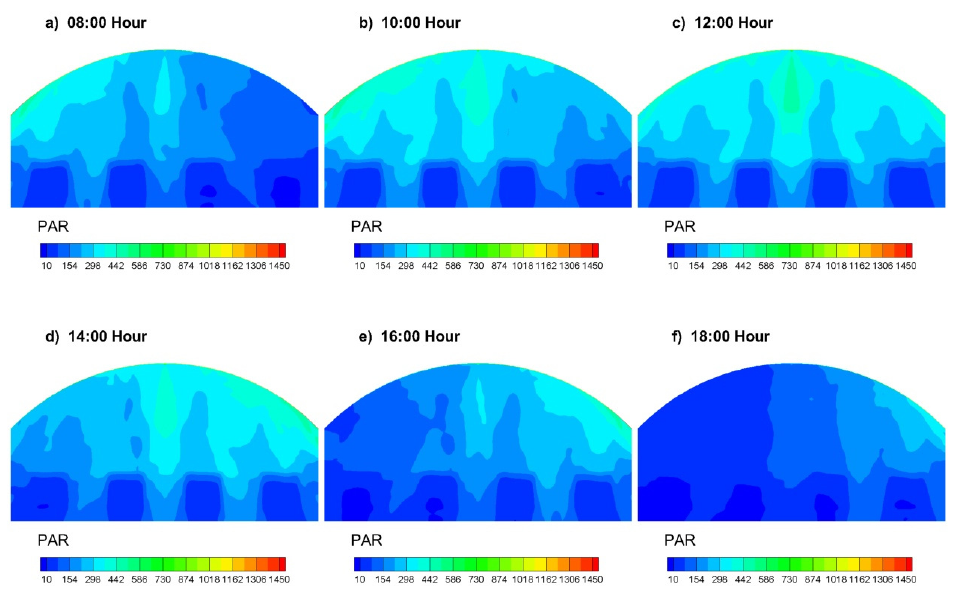
Figure 5. PAR isocontours for 21 June and τ n,PAR = 60%.